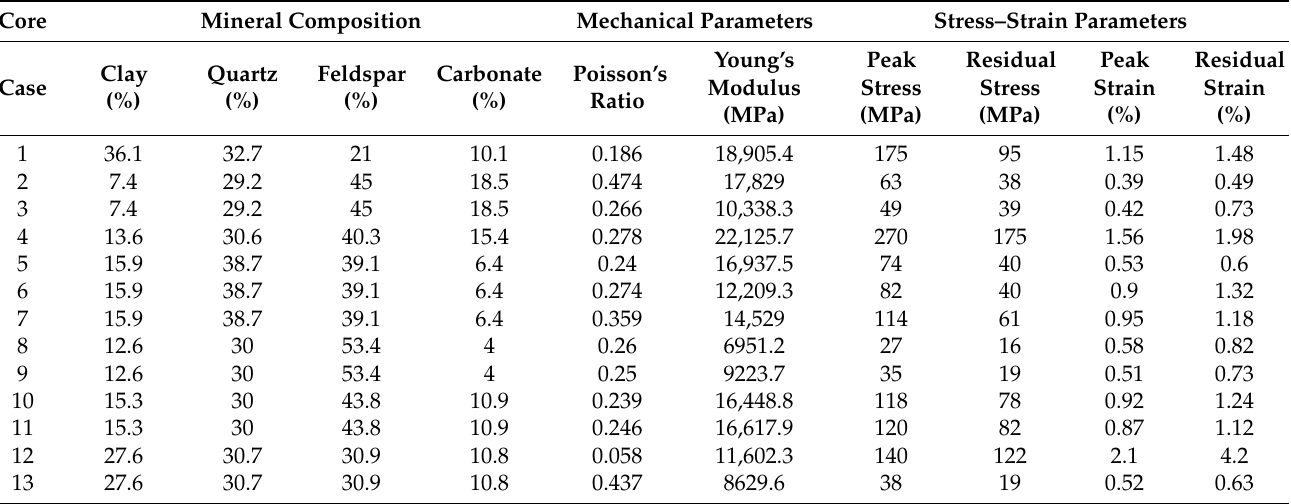
Table 1. Basic parameters of the